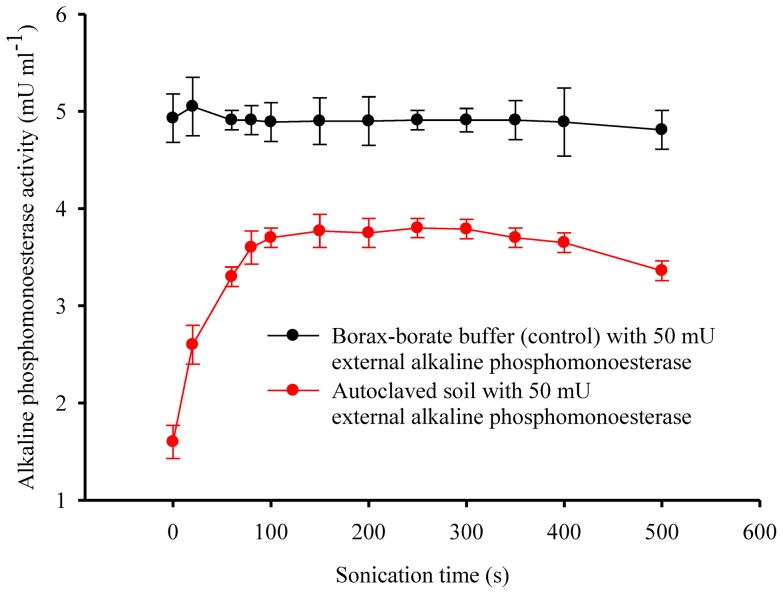
Activity of alkaline phosphatase of the autoclaved soil and the borax-borate buffer (control) with 50 mU external alkaline phosphatase as functions of sonication time.